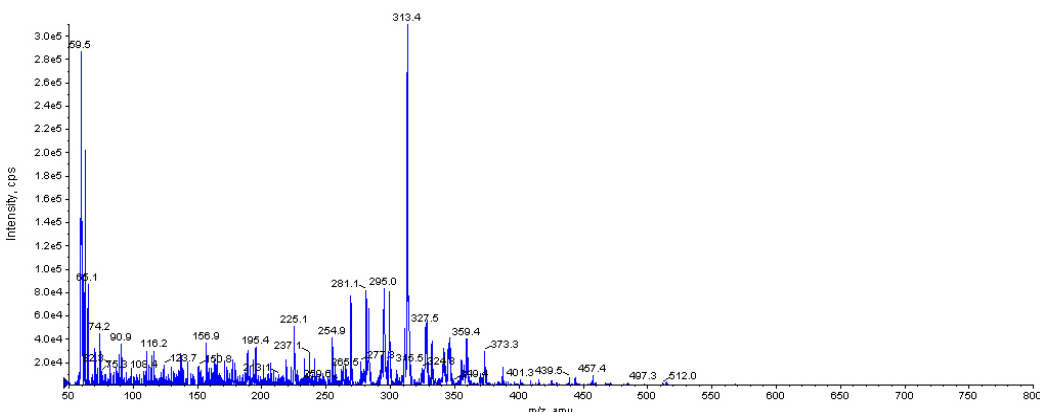
Figure 5. The detection of transformation product by HPLC-MS in negative ion mode (retention time 2.44 min, molecular weight 314.4). The X axis = z/m, the Y axis =